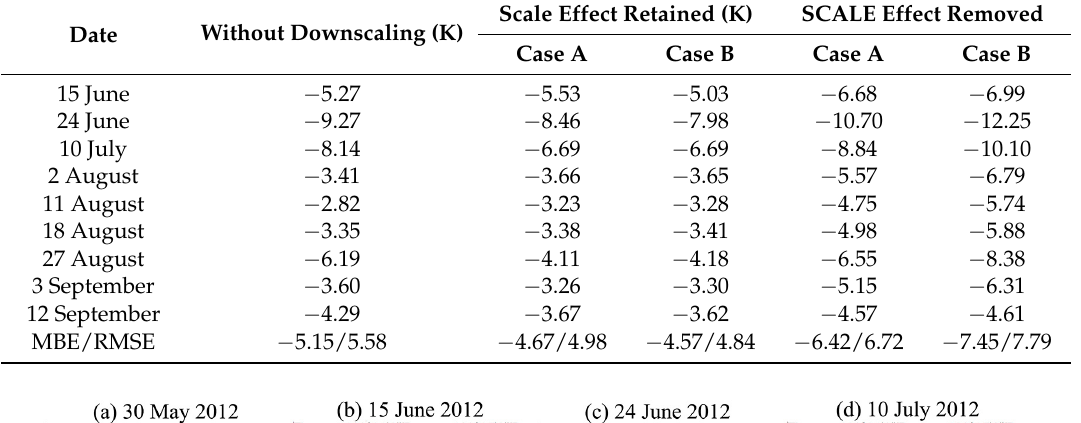
Table 3. Errors of the LSTs downscaled with GRM validated based on in situ LSTs at EC04.